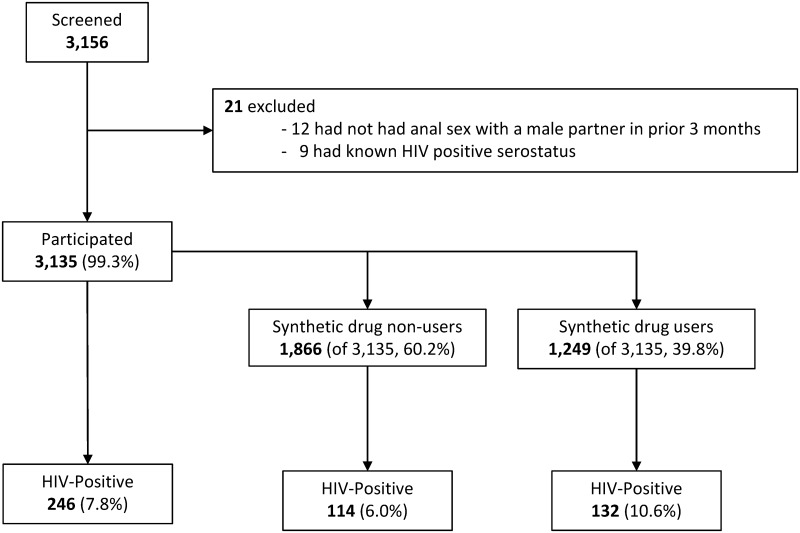
Flow diagram depicting the design of the cross-sectional study conducted among MSM in China.A 39.8% lifetime synthetic drug use prevalence was observed. Overall HIV prevalence was 7.8%, with a higher prevalence among those who had used synthetic drugs in their lifetimes (10.6%) compared to those who had never used these drugs (6.0%).